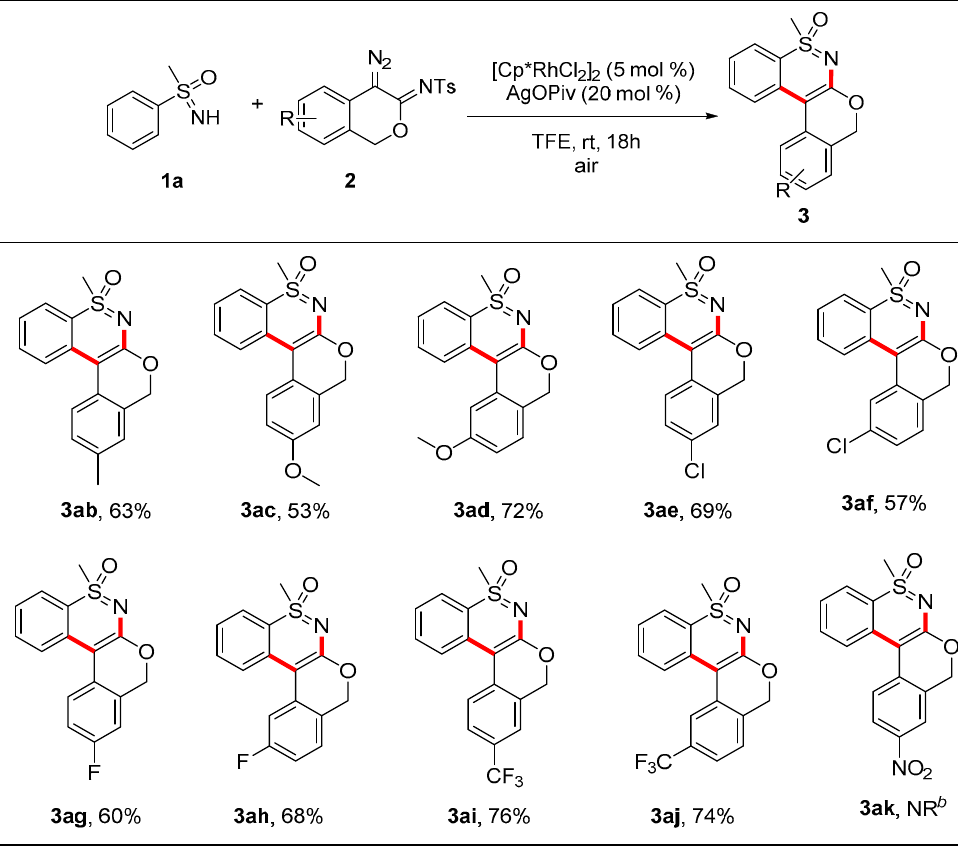
Table 3. Substrate scope of 4-diazoisochroman-3-imines a .